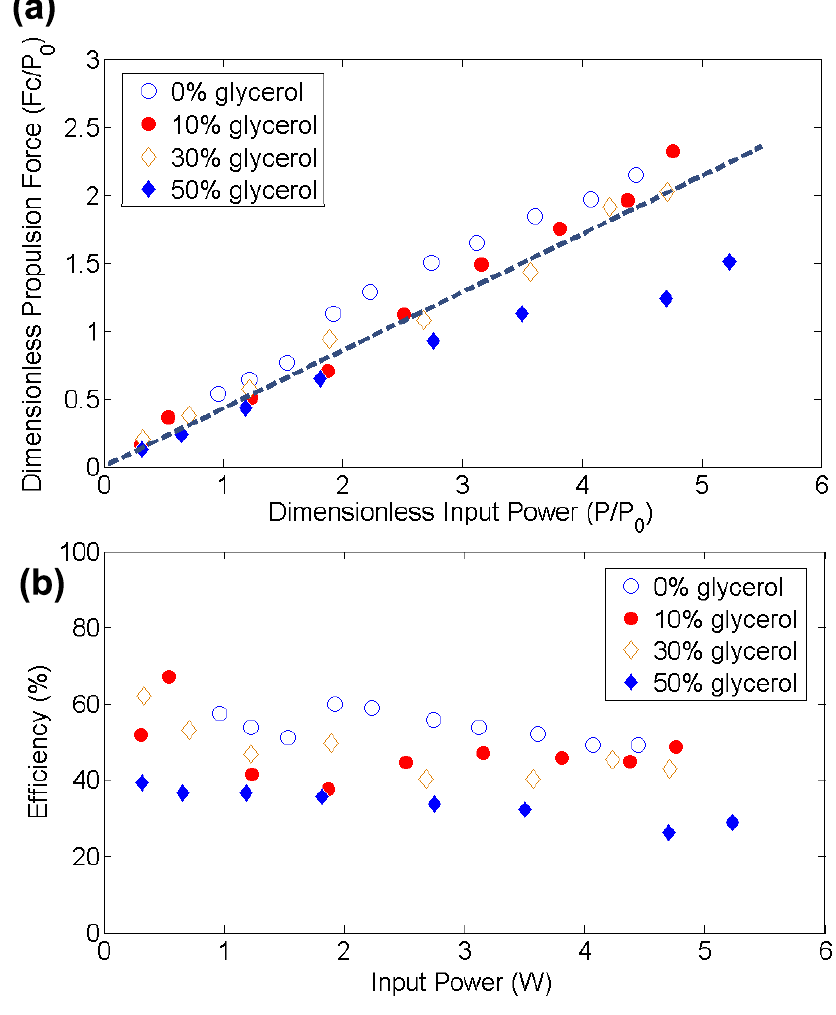
Figure 2. ( a ) Dimensionless propulsion force versus input power in water/glycerol solutions, at 0%, 10%, 30%, and 50% volume of glycerol with the remainder water volume, indicating a linear relationship between the dimensionless propulsion force and input power regardless of the fluid viscosity. ( b ) The electromechanical efficiency of the SAW thruster for propulsion is about 40%-60% depending on the applied input power, with greater efficiency in lower viscosity